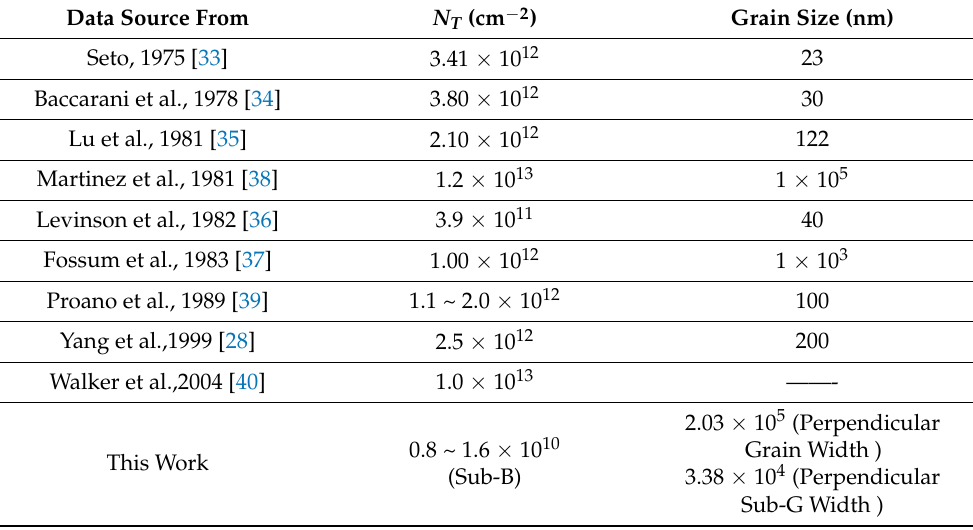
Table 1. Comparison of trap-state density N T and grain size between the GBs in the previous studies and the sub-Bs in the present